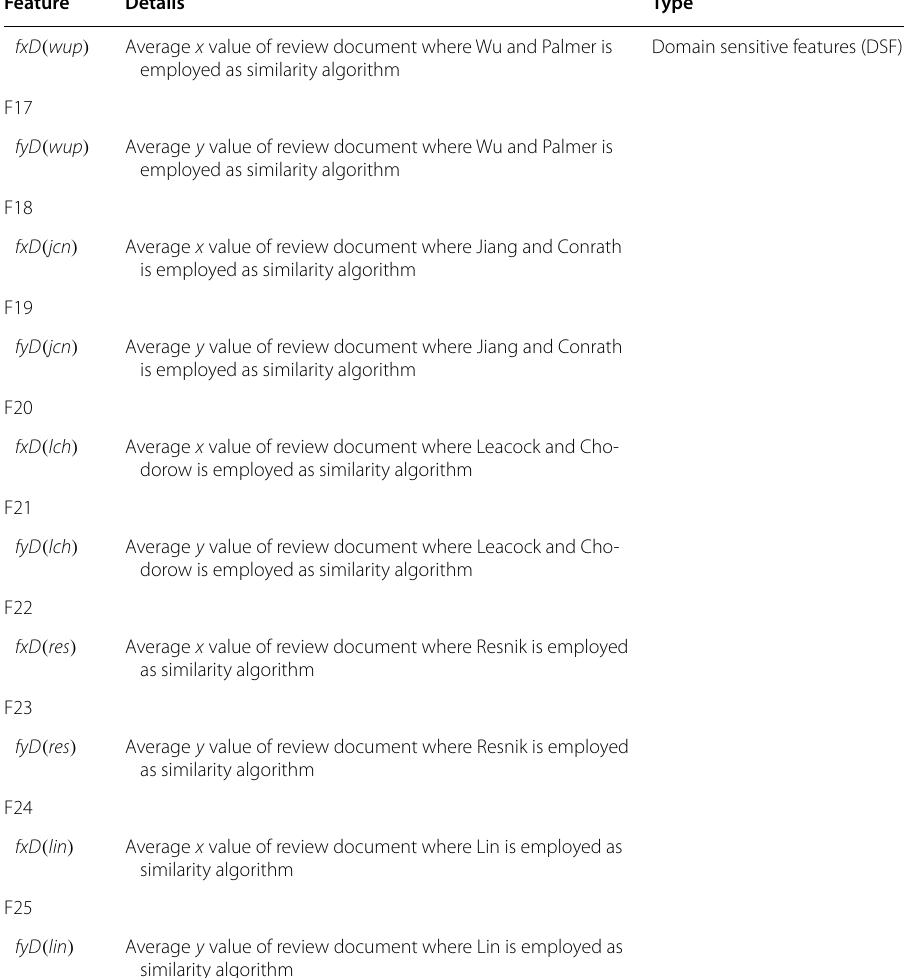
Table 7. We pick the review text for experiment from reviewText. To build the ground truth, we established a label out of three sentiment categories i.e. positive, negative, and neutral for every reviewText based on its overall score. Datasets with overall score 1–2 were assigned as negative reviews. Meanwhile, reviewTexts with overall score 4–5 were labeled positive. And the rest was assigned as neutral